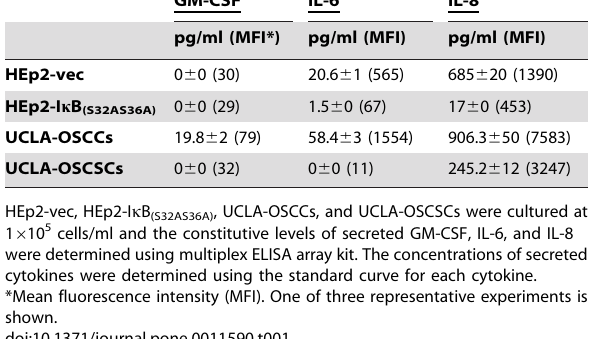
Table 2. Increased ratios of IL-6 to IFN- c secretion in NK resistant UCLA-OSCCs when compared to NK sensitive UCLA-OSCSCs.